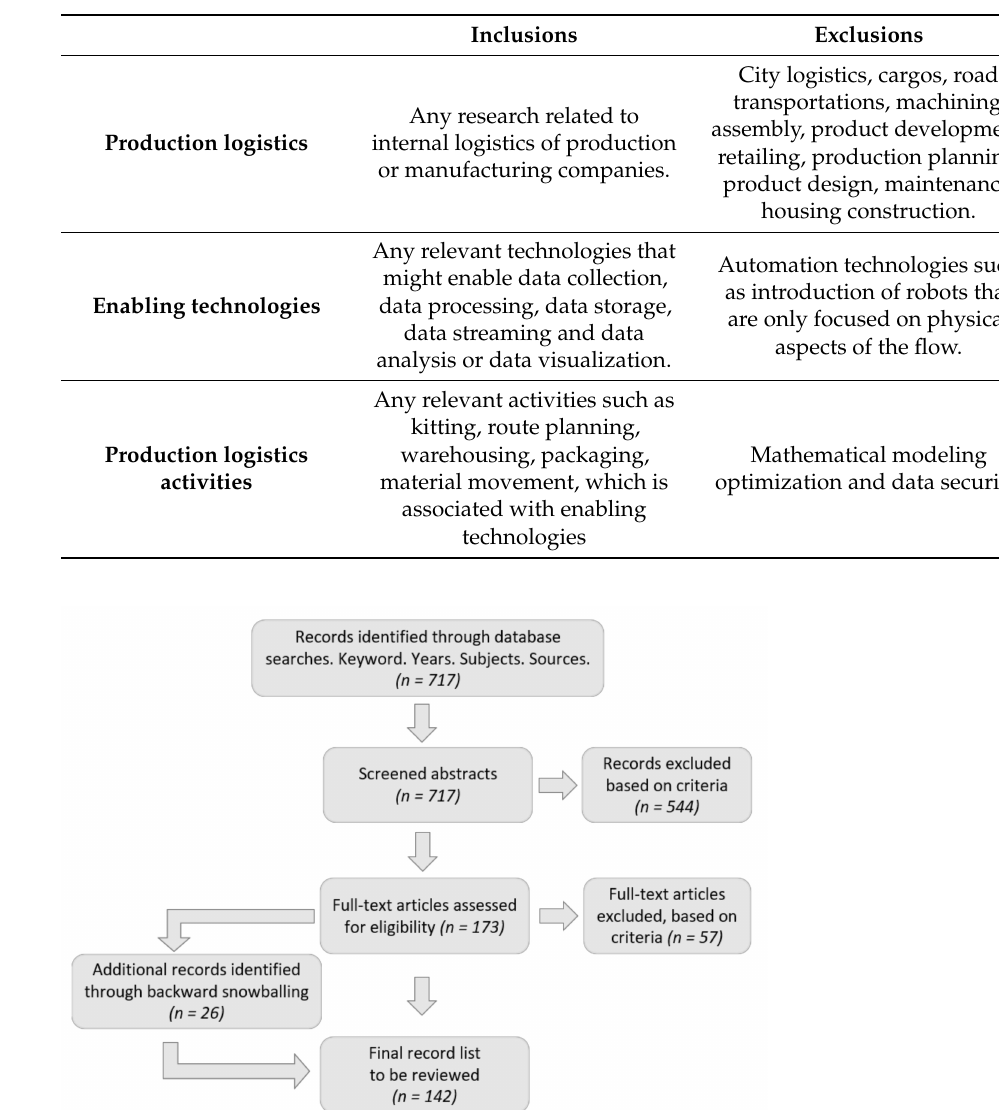
Table 1. Inclusion and exclusion criteria.